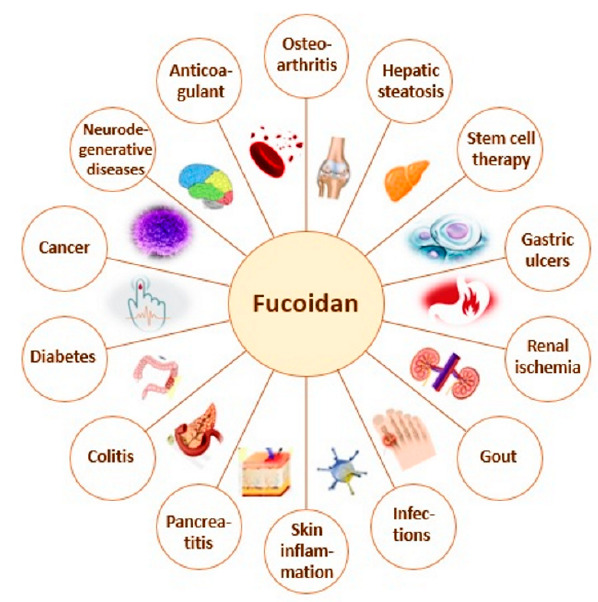
Figure 1. Proposed biomedical applications of fucoidan.